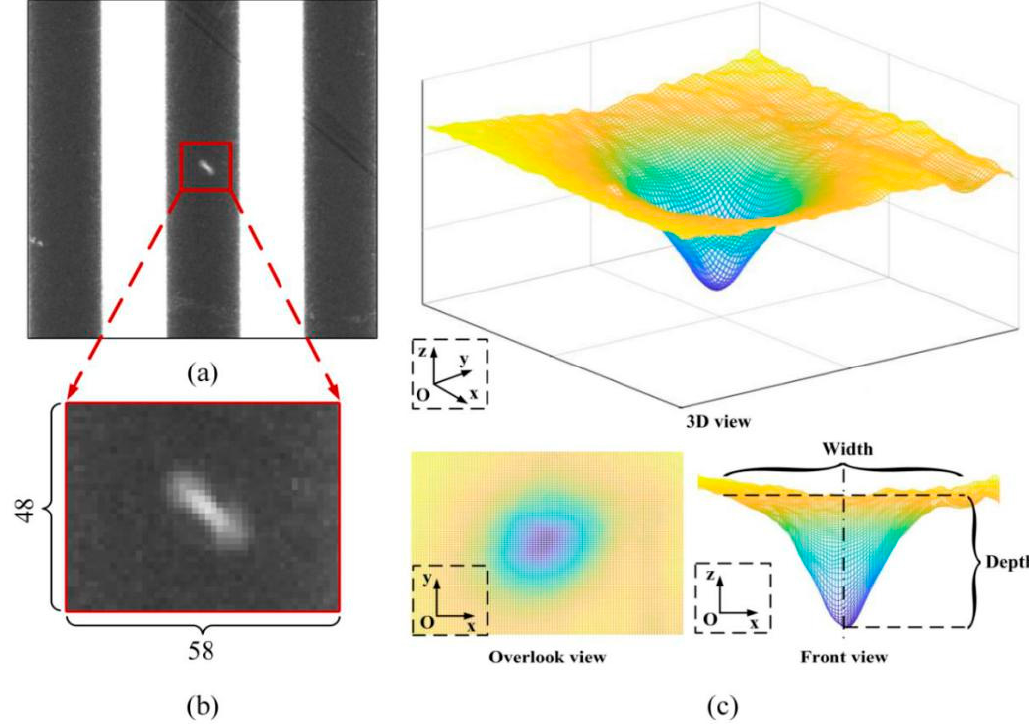
Figure 7. Sample data acquisition. ( a ), ( b ) Example of a saturated image of a defective region, ( c ) Manual labeling method for measuring the shape attributes on laser confocal microscopy images.